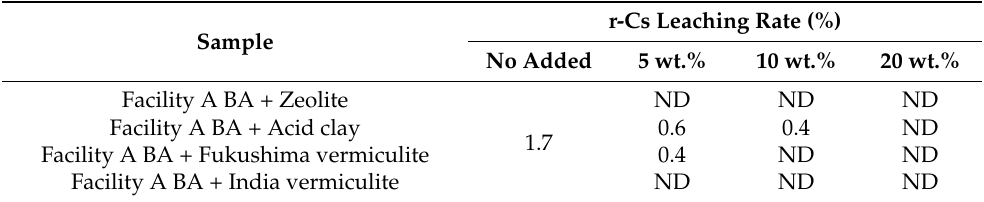
Table 6. Changes in radioactive cesium (r-Cs) leaching rate according to wt.% of clay minerals (bottom ash, BA).